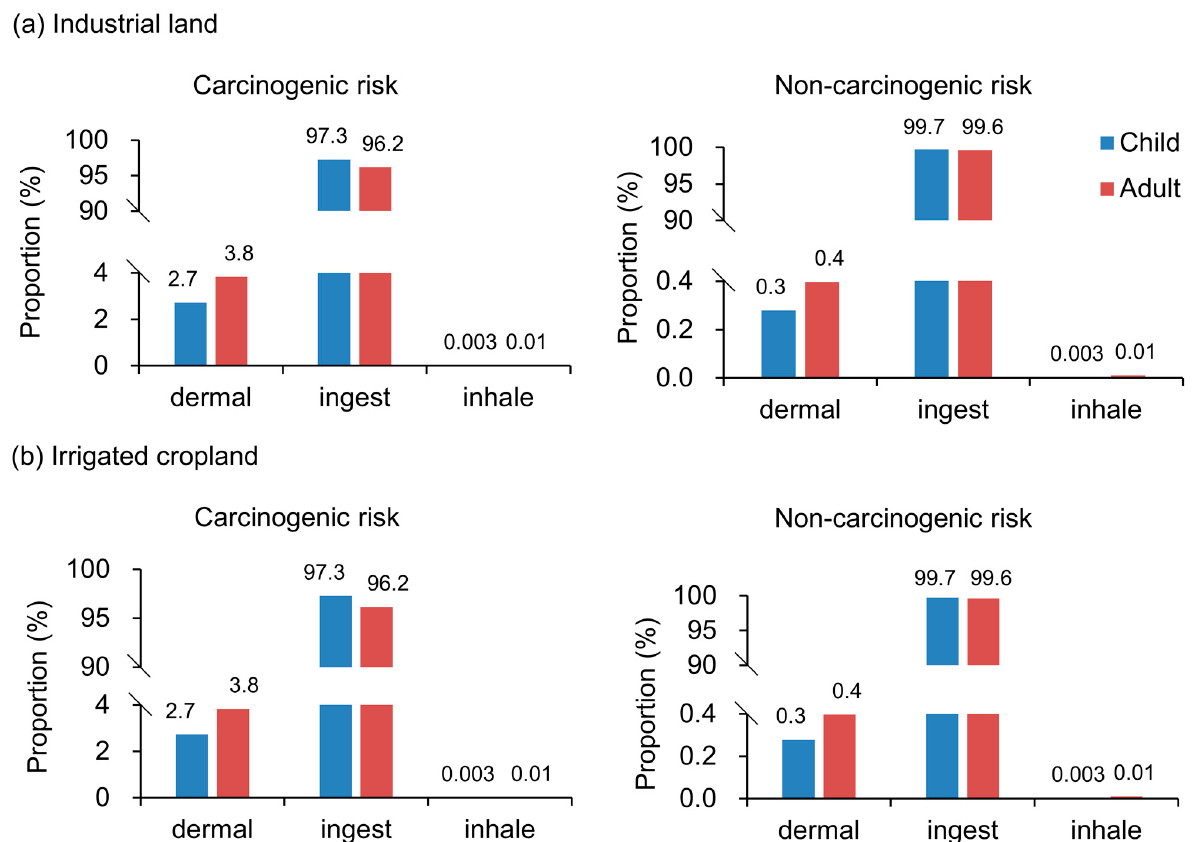
Figure 6. Risk differences of three exposure routes (ingest, dermal, and inhale) in adults and chil- dren. ( a ) Industrial land, ( b ) Irrigated cropland. ( a ) Industrial land, ( b ) Irrigated